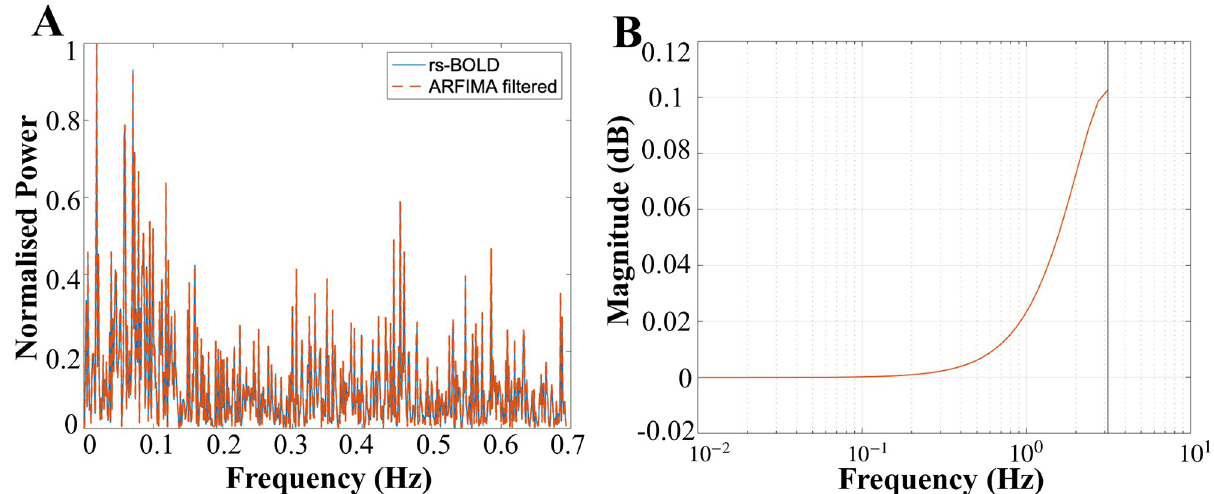
Fig 12. Amplification in the high frequencies for one of the ROI. (A) shows the normalised power spectrum of the resting-state BOLD signal (cyan curve) and the ARFIMA filtered signal (dashed orange curve) for one of the ROI. (B) Magnitude bode plot of the derived ARFIMA filter (for the ROI shown in (A)) depicting amplification in higher